Question: Reading the figure, is the described quantity rising or falling?
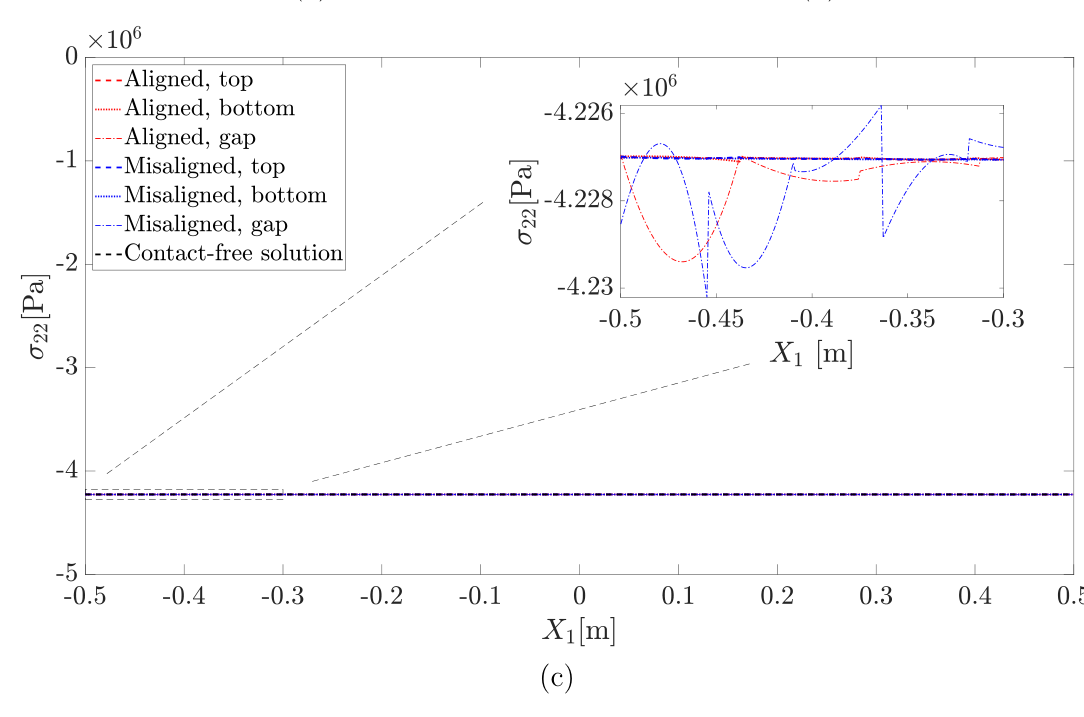
Answer: increasing